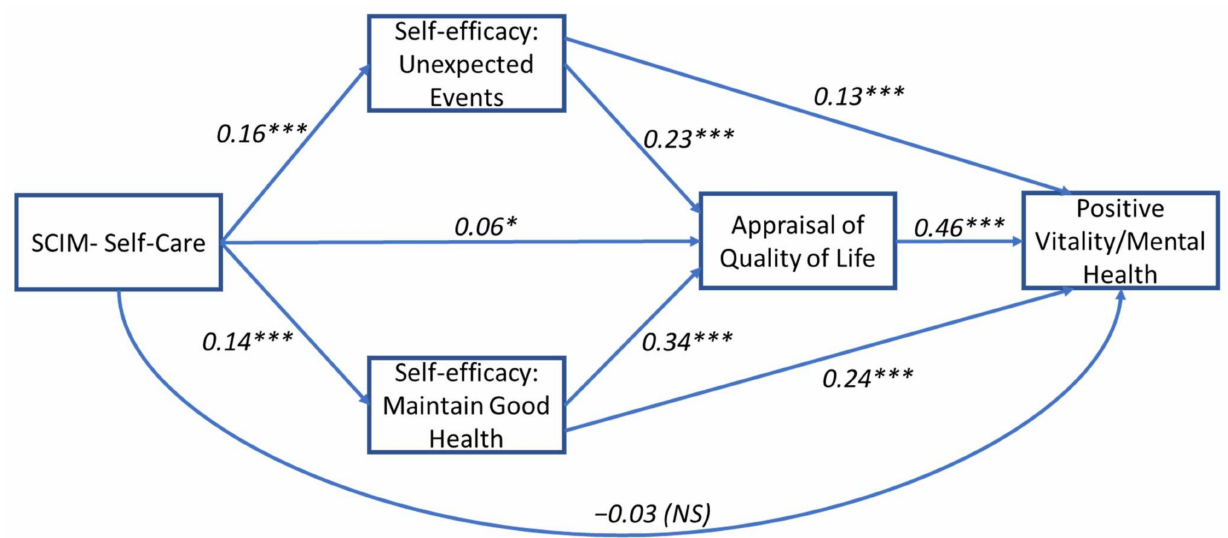
Figure 3. Mediation path model for the relationship between SCIM—Self-Care activities and positive vitality/mental health. Standardized regression coefficients ( β ) are presented for the direct